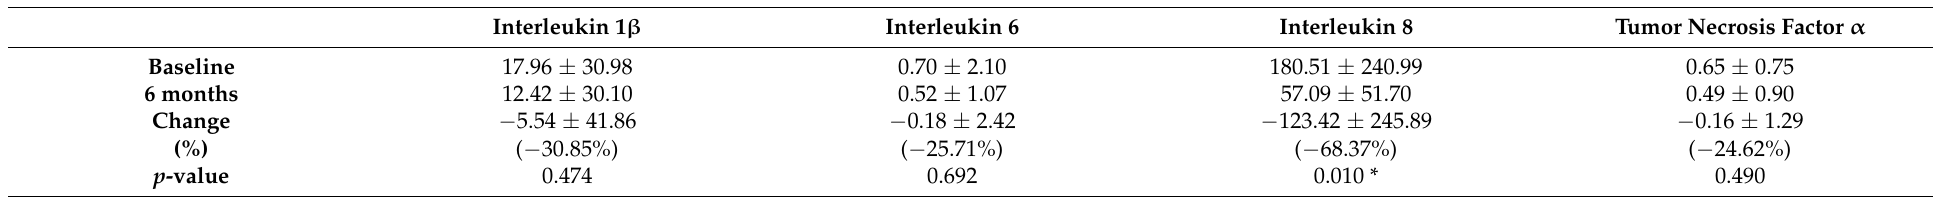
Table 5. Mean values ( ± standard deviation), expressed in pg, and changes in the different biomarkers, expressed in mean values and percentage